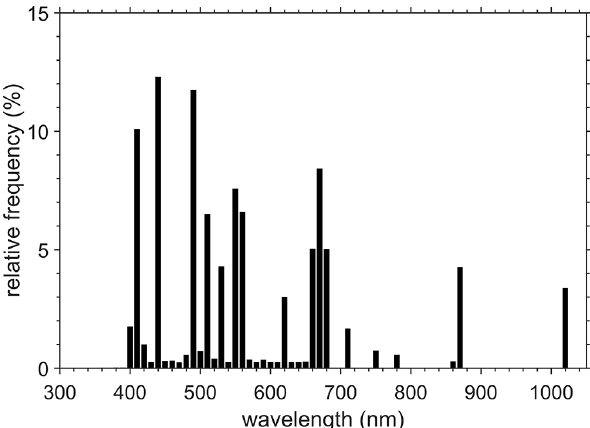
Figure 1. Relative spectral frequency of remote-sensing reflectance in the final table, using 10nm wide class intervals, defined as the ratio of the number of observations at a particular waveband to the total number of observations at all wavebands, multiplied by 100 to report results in percentage. Data at a total of 951 unique wave- lengths, between 313 and 1022.1nm, were